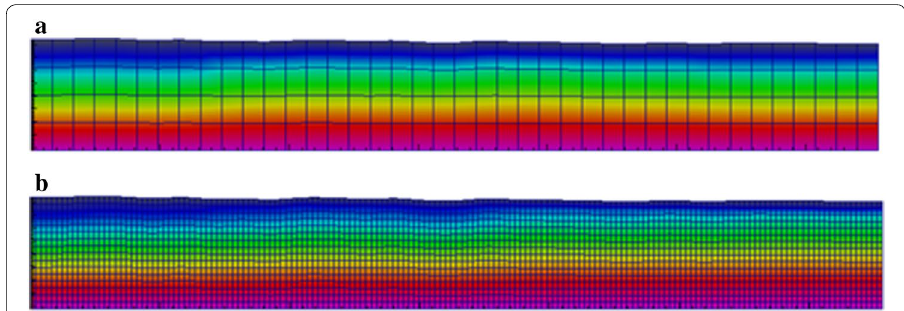
Fig. 4 Example of global refinement values. a Global refinement of 2 and b global refinement of